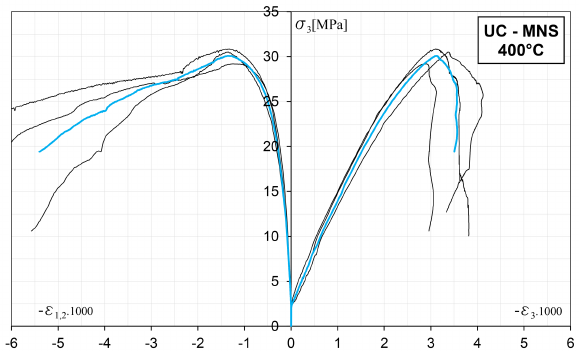
Figure 11. Uniaxial Compression—Axial stress vs. axial and lateral strains curves for Mortar MNS corresponding to a temperature of 400 ◦ C.